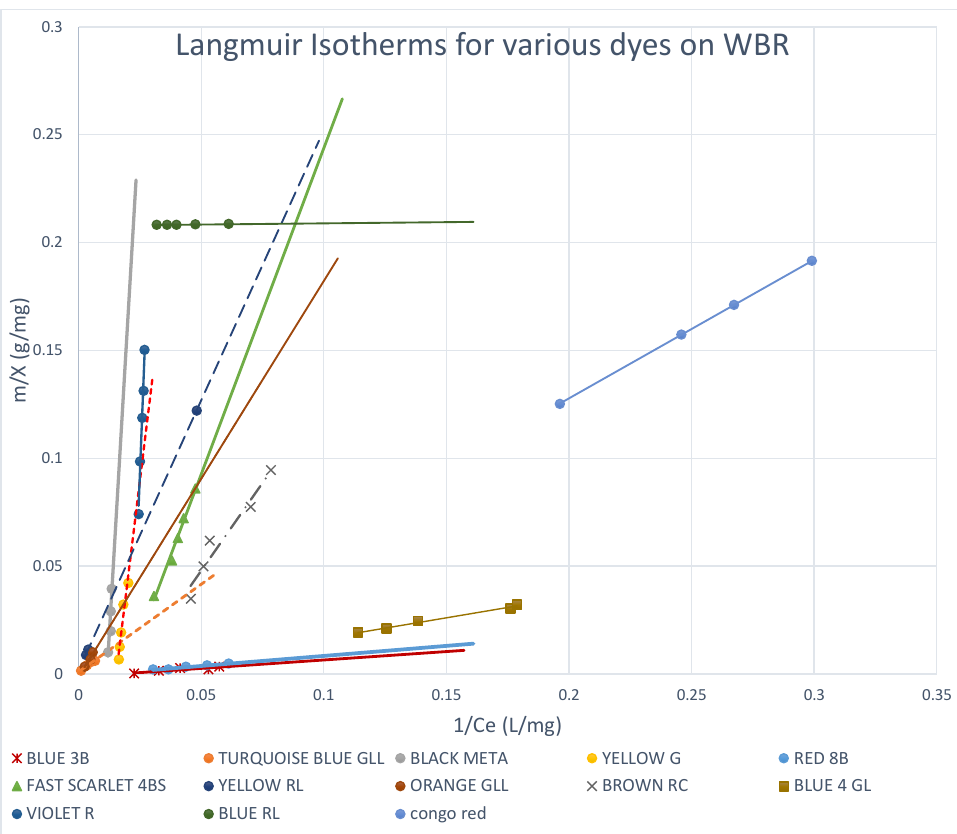
Figure 13. Langmuir isotherms for various dyes on SBR.